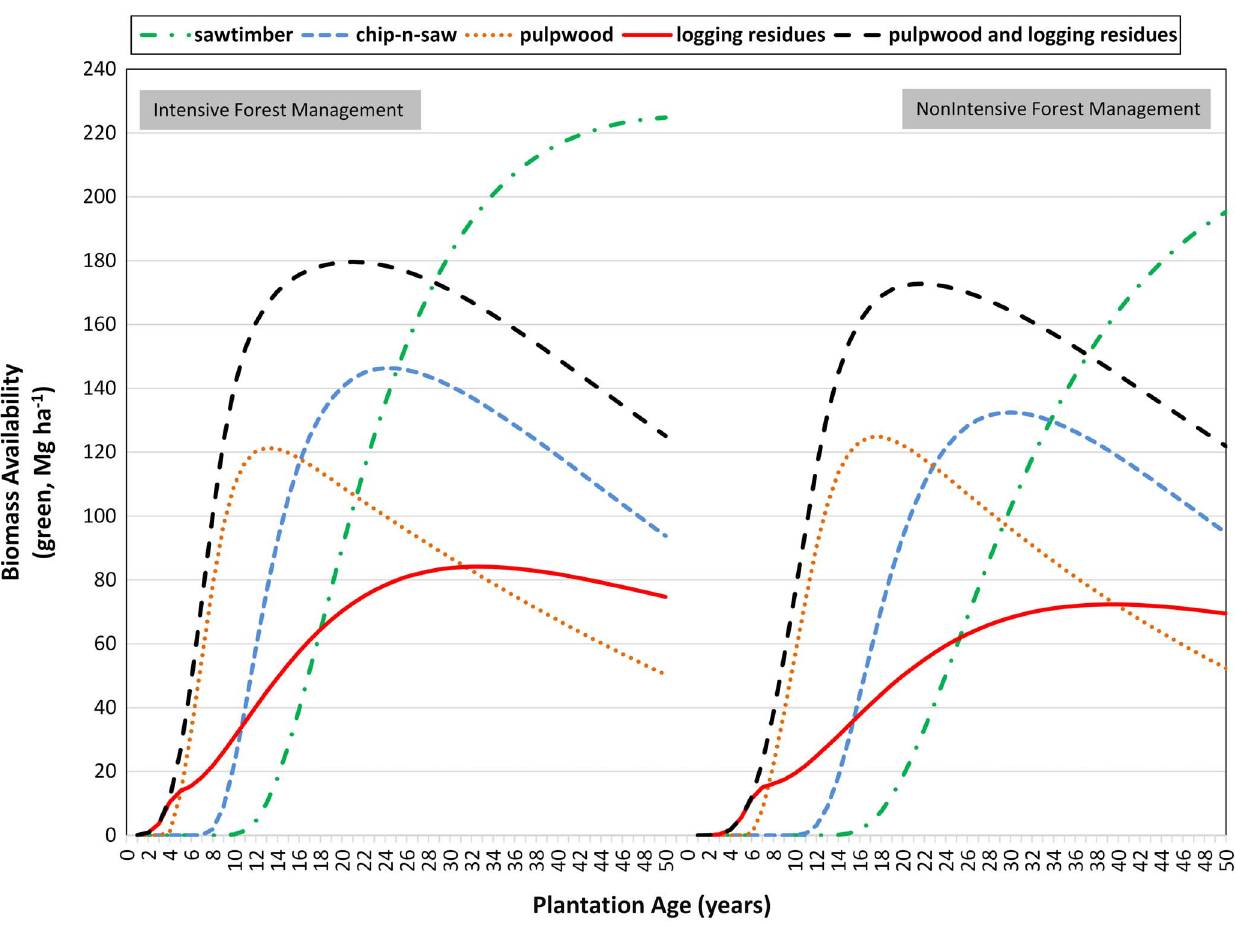
Figure 1. Availability of timber products at different plantation ages. Site index is 21.4 meters at 25 th year of plantation. Initial plantation density is 1236 seedlings ha 2 1 .